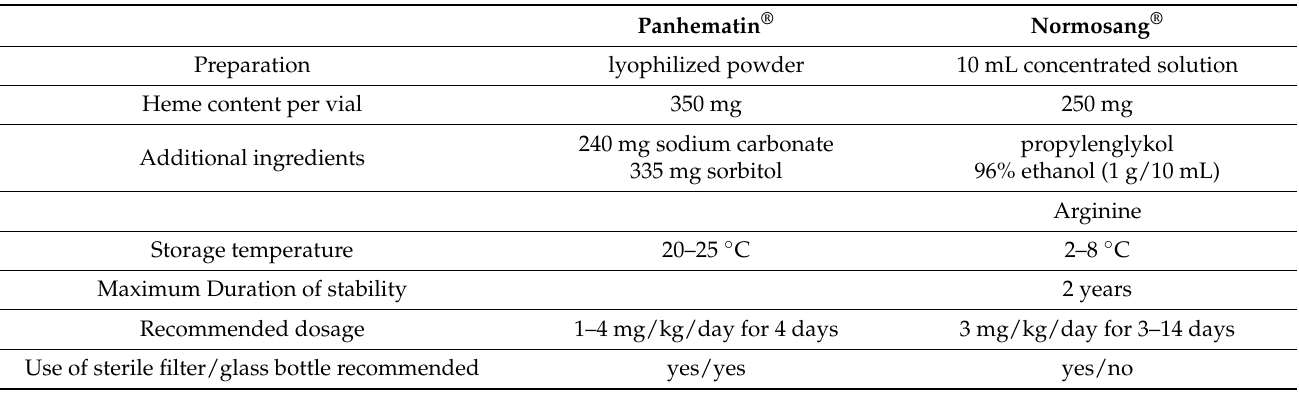
Table 2. Panhematin ® (US) and Normosang ® (Europe) Preparations in 2022 (both manufactured and distributed by Recordati Rare Diseases Inc., Milan,